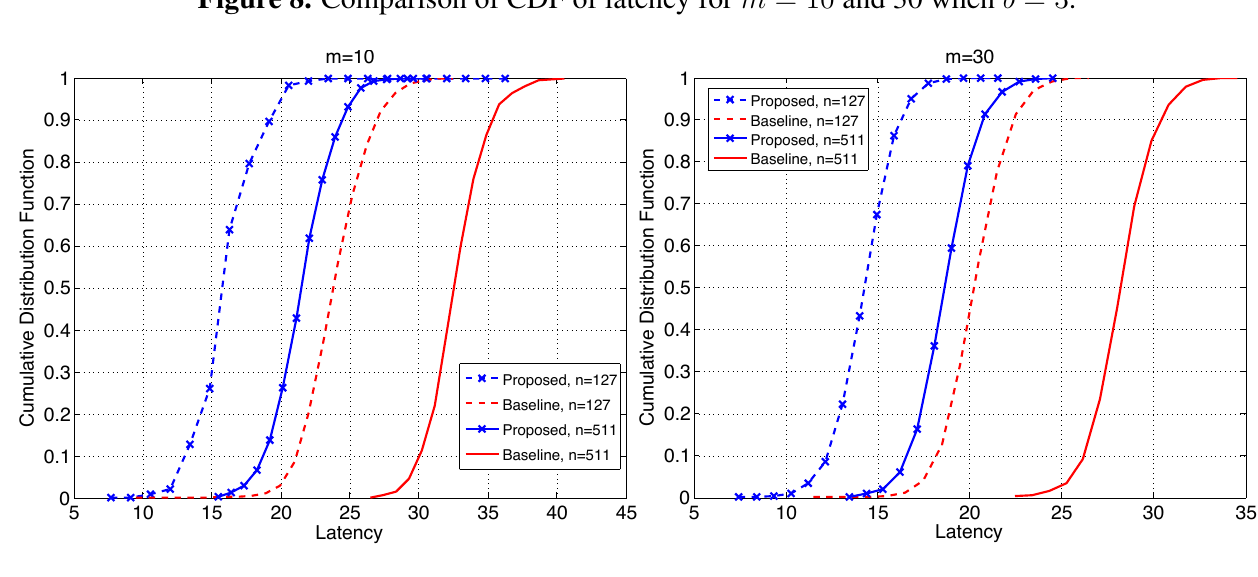
Figure 8. Comparison of CDF of latency for m = 10 and 30 when b = 3